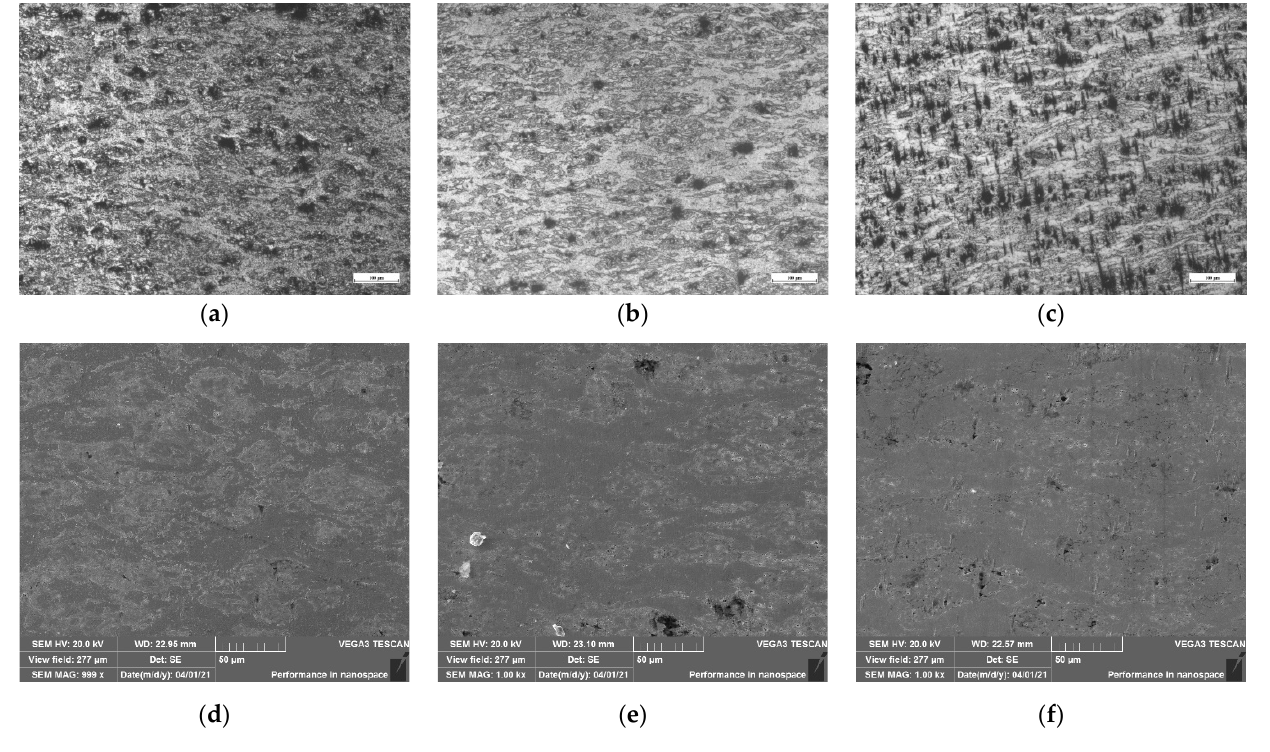
Figure 11. Microstructure of Zr-6Al-0.1B alloy at 0.1 s − 1 : ( a ) OM image of 950 °C; ( b ) OM image of 1050 °C; ( c ) OM image of 1150 °C; ( d ) SEM image of 950 °C; ( e ) SEM image of 1050 °C; ( f ) SEM image of 1150 °C.